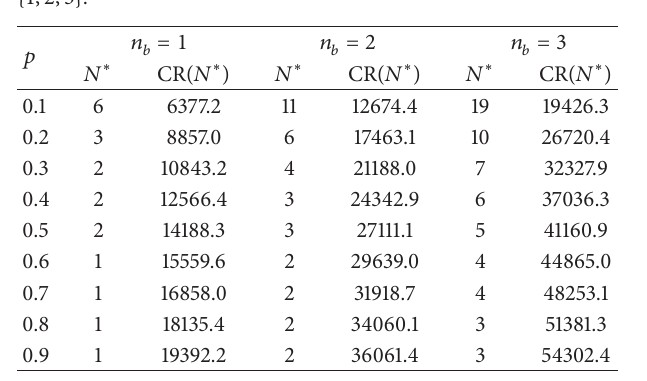
Table 2: 𝑁 ∗ and CR (𝑁 ∗ ) for 𝑝 ∈ {0.1 , 0.2 , .. ., 0.9} and 𝑛 𝑏 ∈ {1,2, 3}